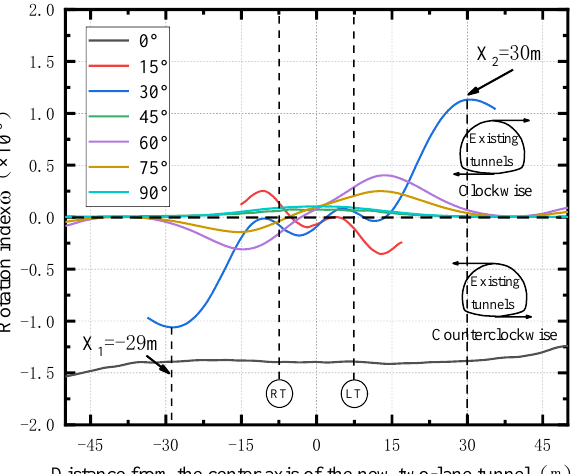
Figure 22. Longitudinal rotation index of the existing tunnel with different spatial intersection an- gles.